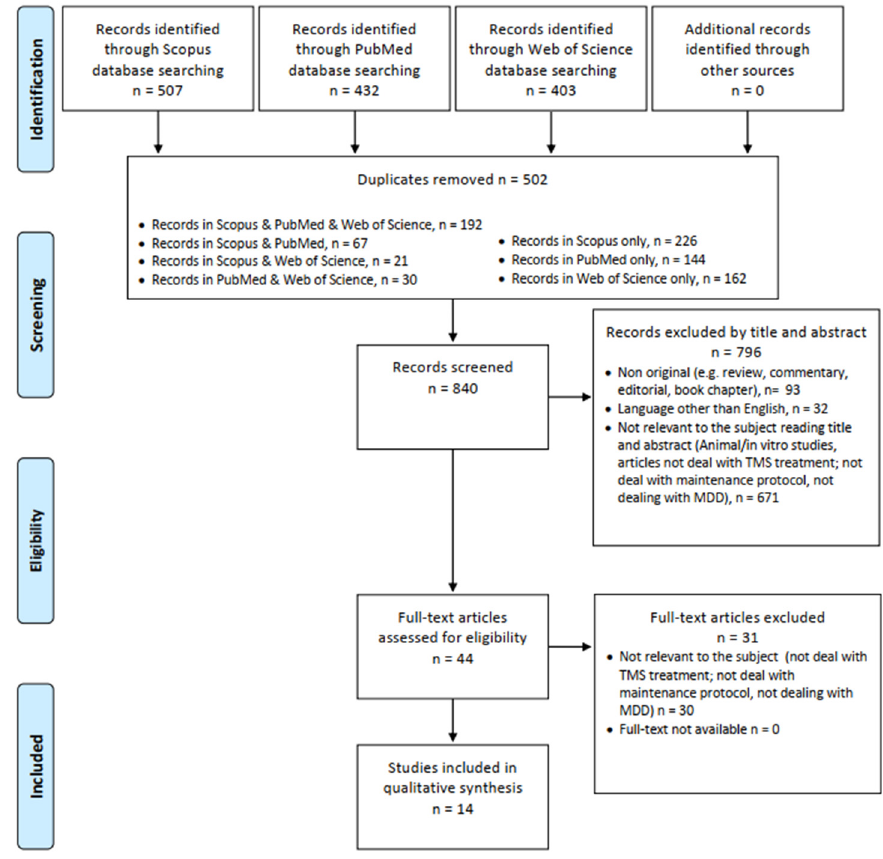
Figure 1. PRISMA fl ow diagram. Figure 1. PRISMA flow